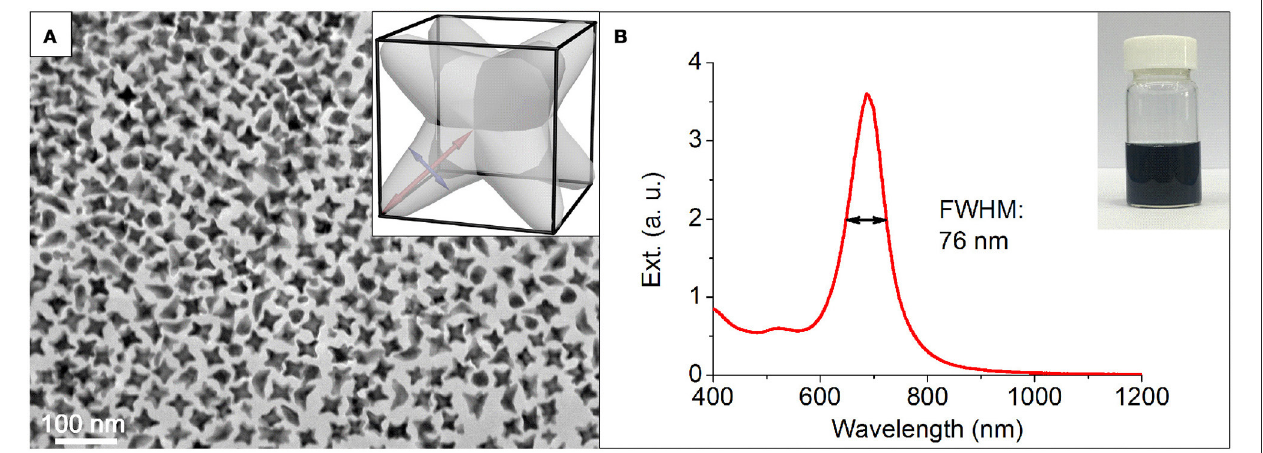
FIGURE 2 | (A) HRTEM image of an individual NOP. (B) Powder X-ray Diffraction of the NOPs. (C) 3D-TEM images of NOPs tilted from ca. − 40 ◦ to + 40 ◦ . (D) Corresponding 3D model images with same views from ca. − 40 ◦ to + 40 ◦ .